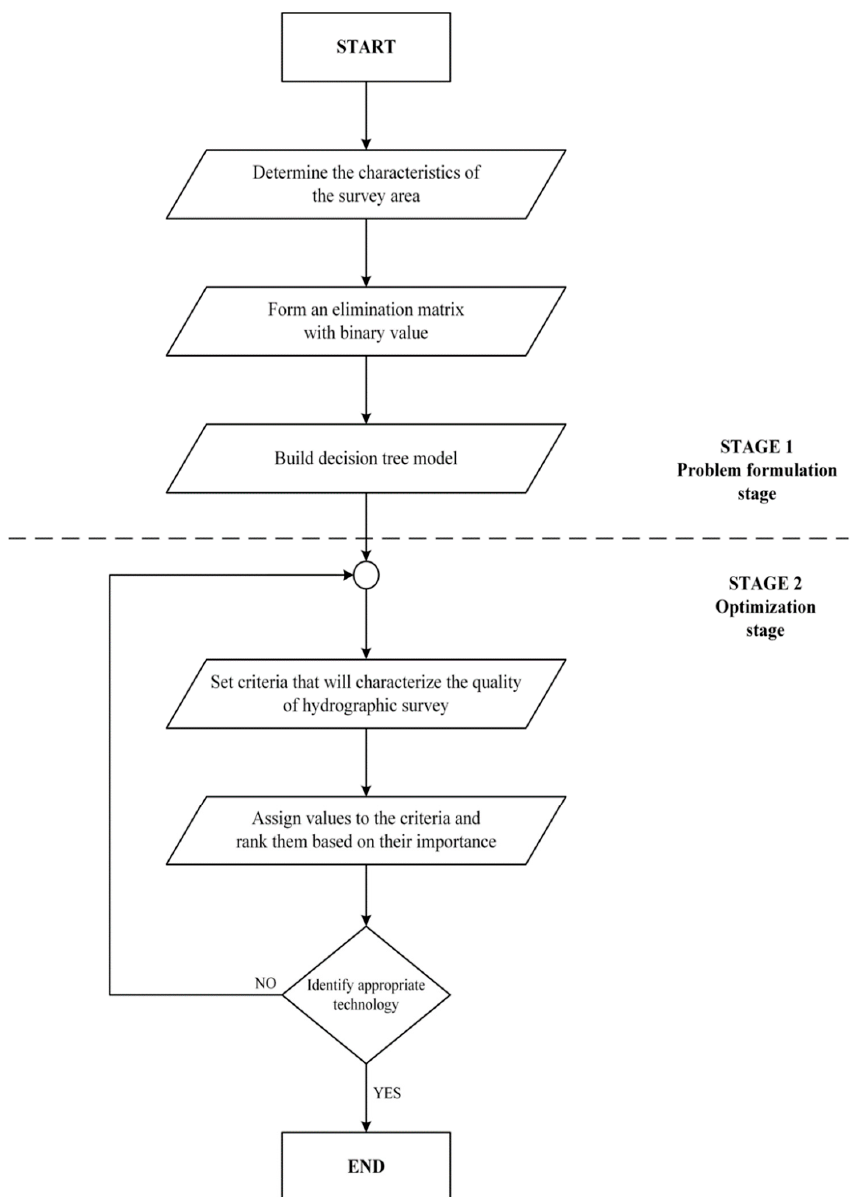
Figure 1. The process of identifying the appropriate